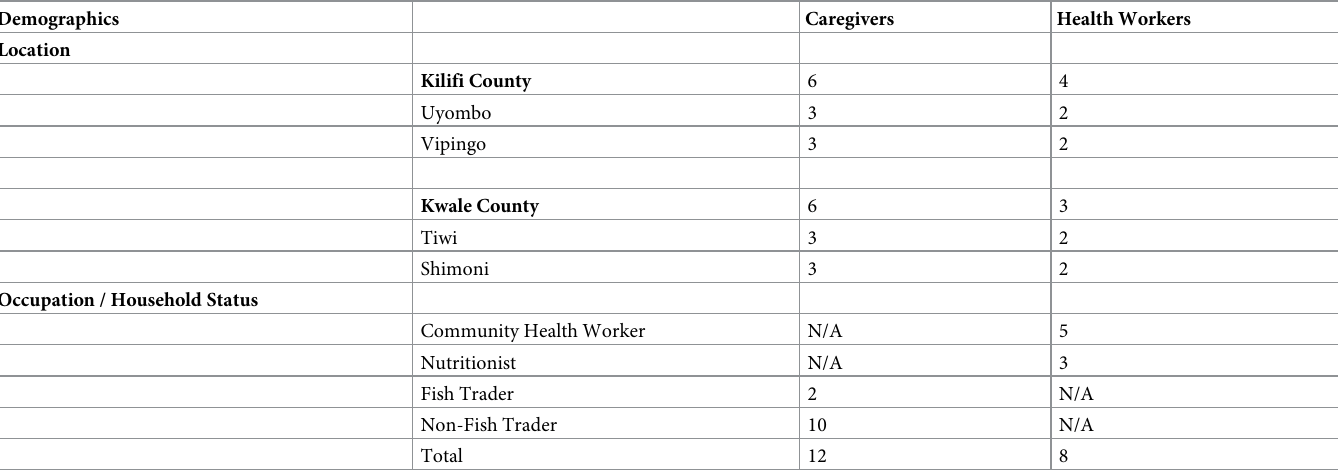
Table 2. Interview participant demographic characteristics.